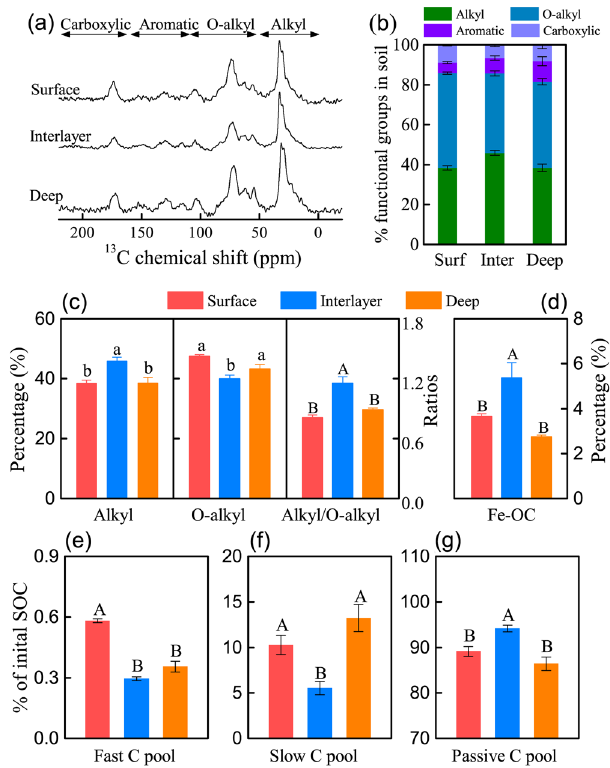
Fig. 2 Comparison of carbon composition, mineral-protected organic carbon, and carbon pool sizes in the three water table-dependent soil layers. a 13 C CPMAS NMR spectra. The following forms of carbon were analyzed in the spectra: alkyl-C, chemical shifts of 0 – 50 ppm; O-alkyl-C, 50 – 110 ppm; aromatic-C, 110 – 165 ppm; and carboxylic C, 165 – 220 ppm. b Relative percentages of the four forms of carbon relative to total SOC. Surf surface, Inter interlayer. c Percentages of alkyl-C or O-alkyl-C and the ratio of alkyl-C to O-alkyl-C. Percentages are plotted on the left vertical axis and ratios on the right vertical axis. d Percentage of Fe-bound organic carbon (Fe-OC). e – g three carbon pool size. Error bars denote SE ( n = 3). Uppercase letters, p < 0.01; lowercase letters, p < 0.05 (Tukey HSD test). SOC soil organic three layers. The proportion of alkyl-C was signi fi cantly higher at the interlayer (45.8%) than at the surface (38.4%) or deep soil (38.1%; both p < 0.05). Conversely, the proportion of O-alkyl-C surface (47.5%) or deep soil (43.2%; both p < 0.05). The calculated